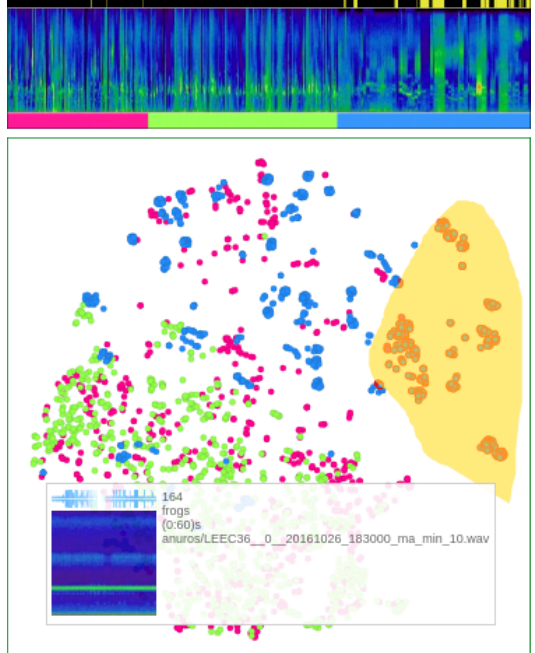
Figure 3. Example of visual iteration with Time-Line-Spectrogram (TLS): the points selected in the yellow color area in the projection are also visualized with yellow color in the spectrogram timeline (top of figure). In this view, projection multidimensional t-SNE is used for visualizing each data